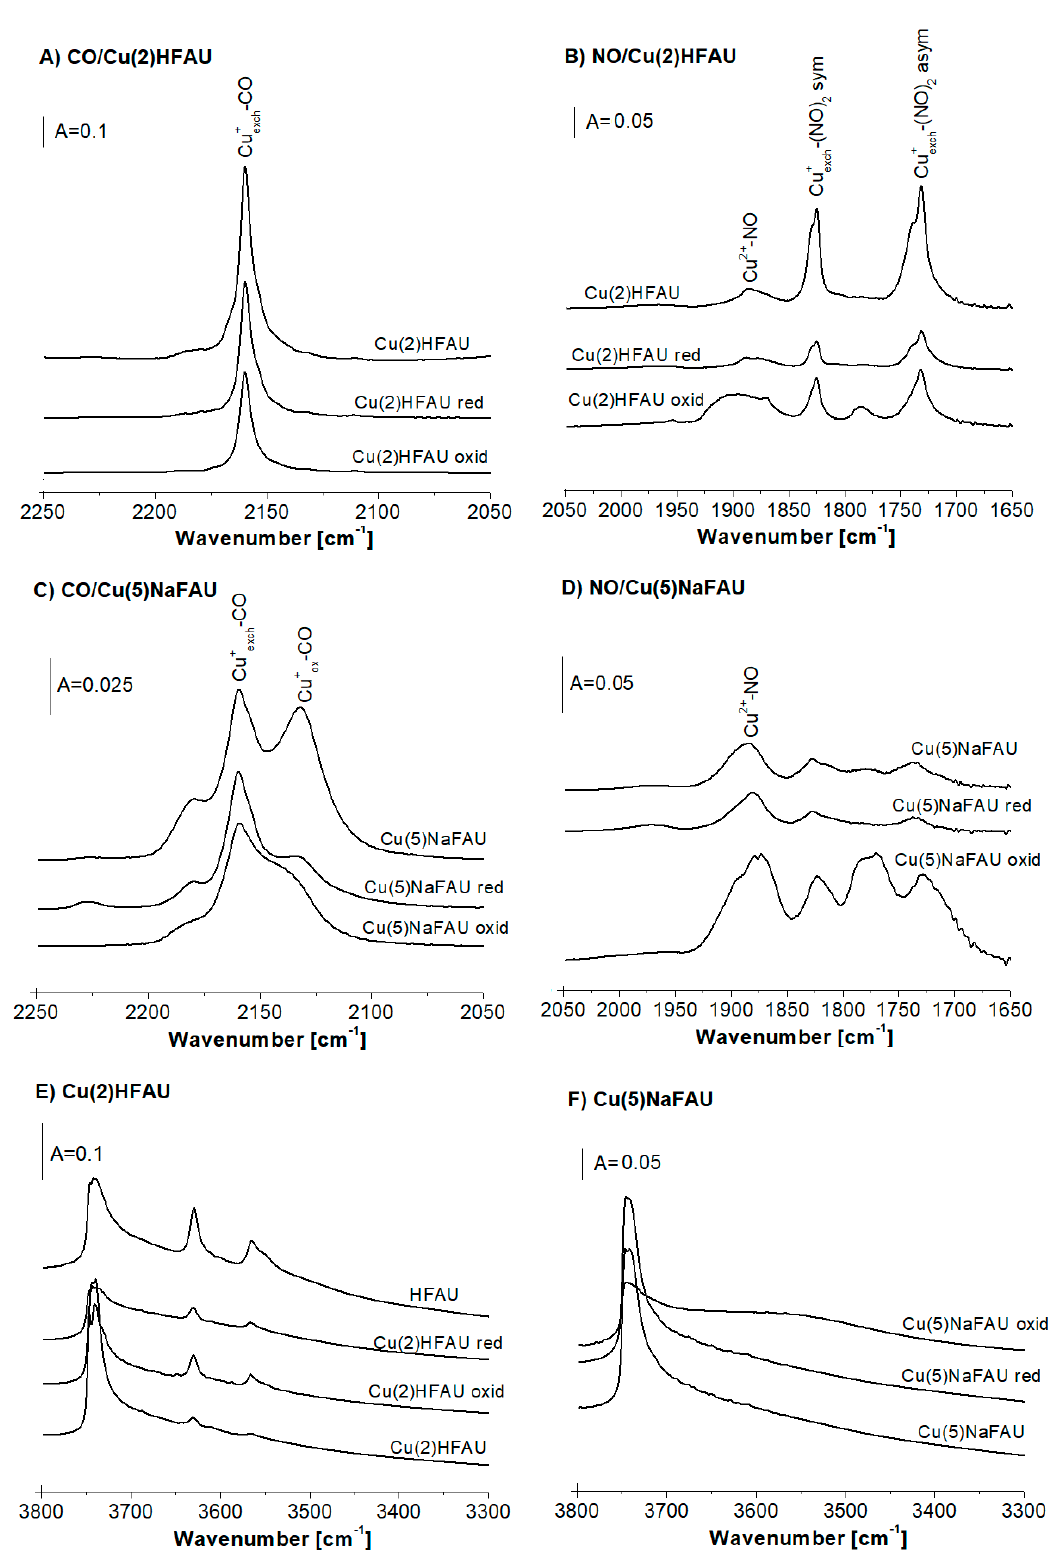
Figure 4. ( A – D ) The IR spectra of CO and NO sorbed at room temperature (CO) and at 190 K (NO) on Cu(2)HFAU and Cu(5)NaFAU zeolites, and the same samples reduced in hydrogen at 570 K and oxidized in oxygen at 570 K. ( E , F ) The IR spectra of the OH groups in Cu(2)HFAU ( E ) and in the Cu(5)NaFAU zeolite ( F ).